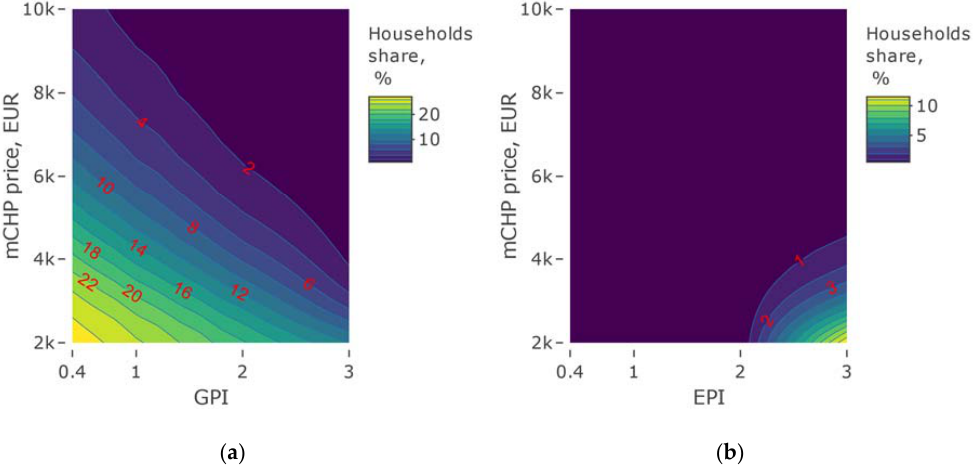
Figure 14. The household share for: ( a ) EPI = 3.0 and di ff erent GPI; ( b ) GPI = 3.0 and di ff erent EPI.